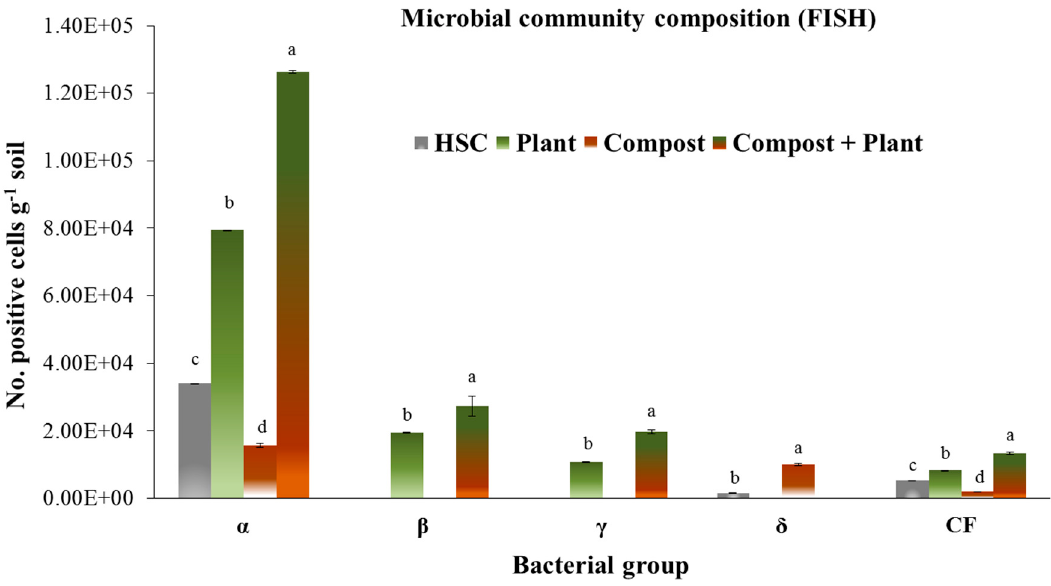
Figure 7. Microbial community structure assessed at day 224 in the various treatments by Fluorescence In Situ Hybridization (FISH), expressed as number of positive cells (No. positive cells g − 1 soil). HCS: historically contaminated soil; Compost: historically contaminated soil amended with municipal solid waste compost; Plant: historically contaminated soil with Medicago sativa plant; Compost + Plant: historically contaminated soil amended with the compost, in the presence of Medicago sativa plant. α : α -Proteobacteria ; β : β - Proteobacteria ; γ : γ - Proteobacteria ; δ : δ - Proteobacteria ; CF: Cytophaga-Flavobacterium-Bacteroidetes (CFB group). Lowercase letters indicate significant differences (p < 0.05) among treatments within the same microbial group.